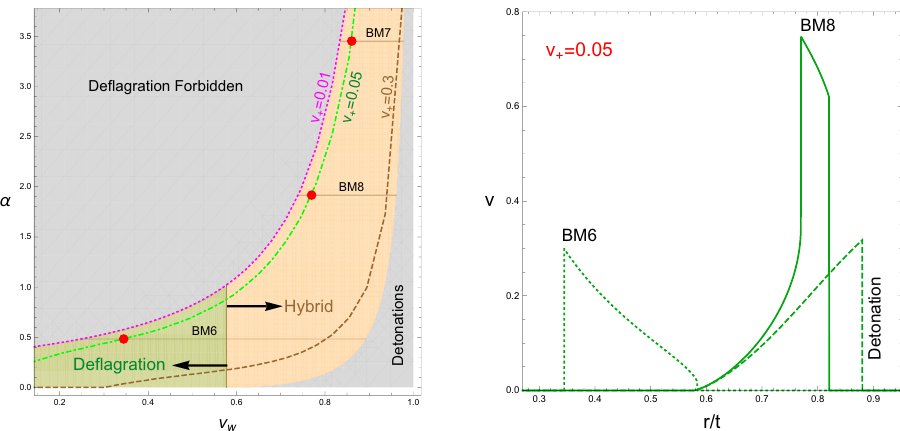
Figure 1 . Left panel: constraint on the plane ( v w ; (cid:11) ) from hydrodynamic considerations. Right panel: representative velocity pro(cid:12)les for plasma surrounding the bubble wall for each of the three modes with r the distance from the bubble wall center and t starting from the onset of the phase transition. See text for detailed